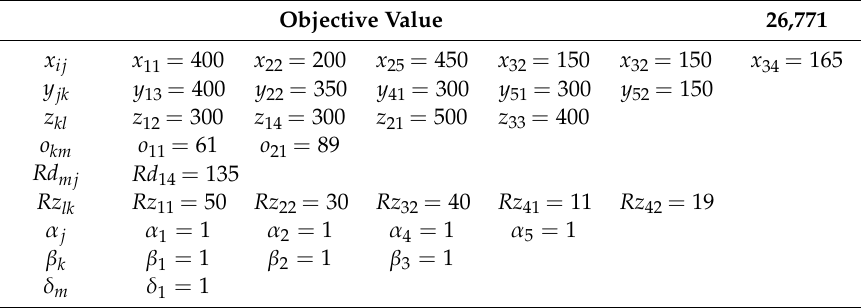
Table 10. The optimal solution of Experiment 3.